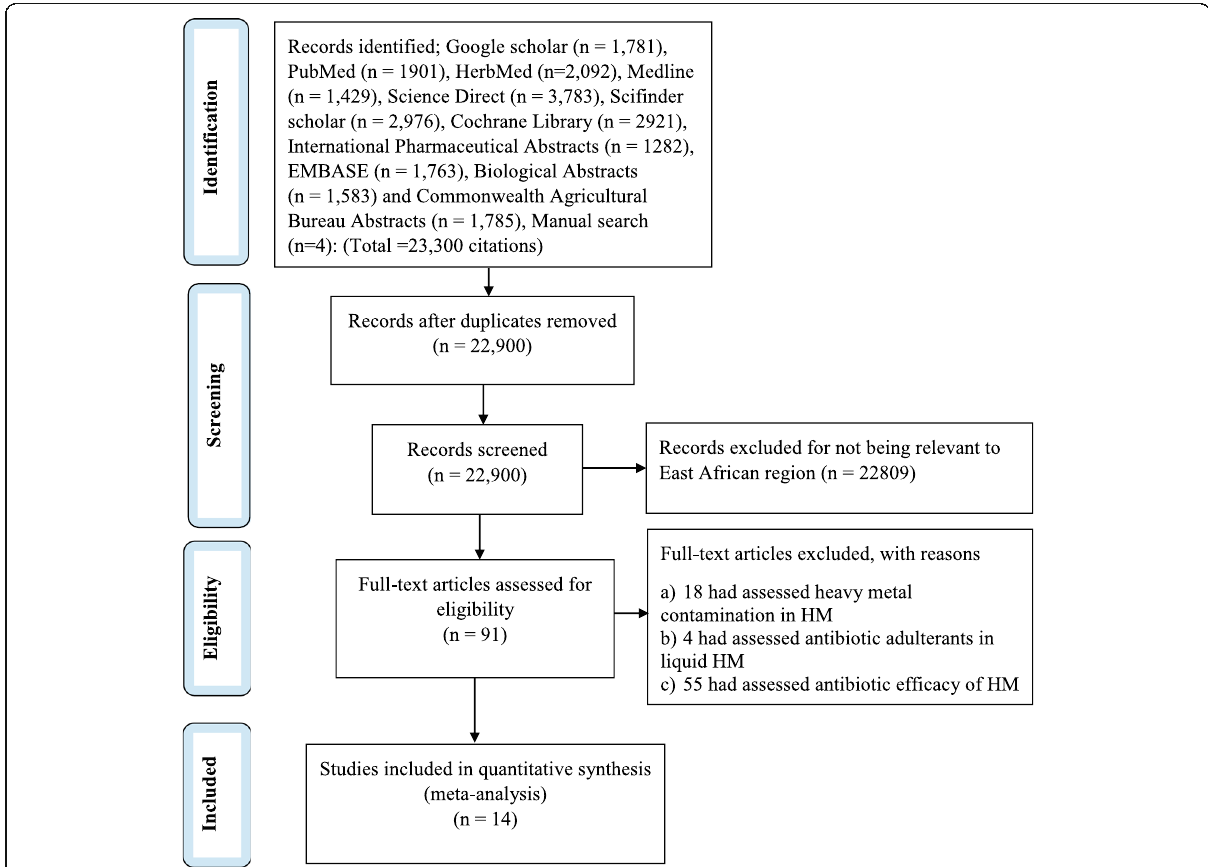
Fig. 1 Flow chart for study eligibility screening of the research articles related to bacterial contamination of herbal medicines in East Africa, following PRISMA criterion